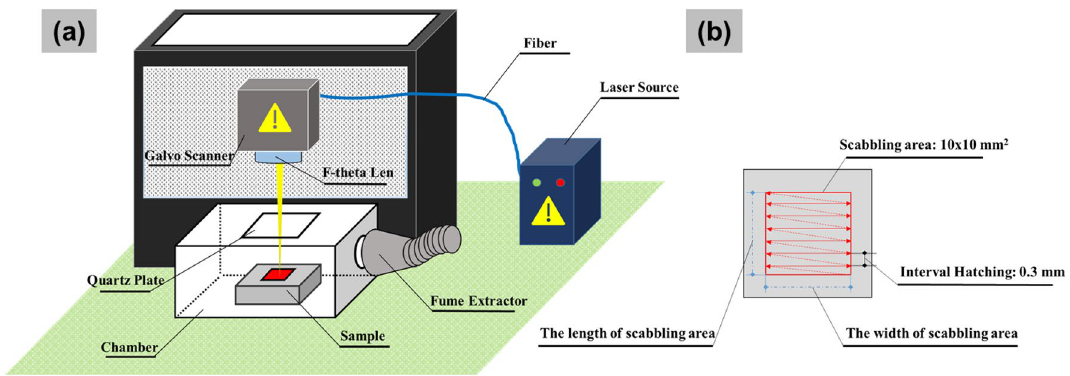
Figure 1. ( a ) Experimental setup, ( b ) Laser scabbling